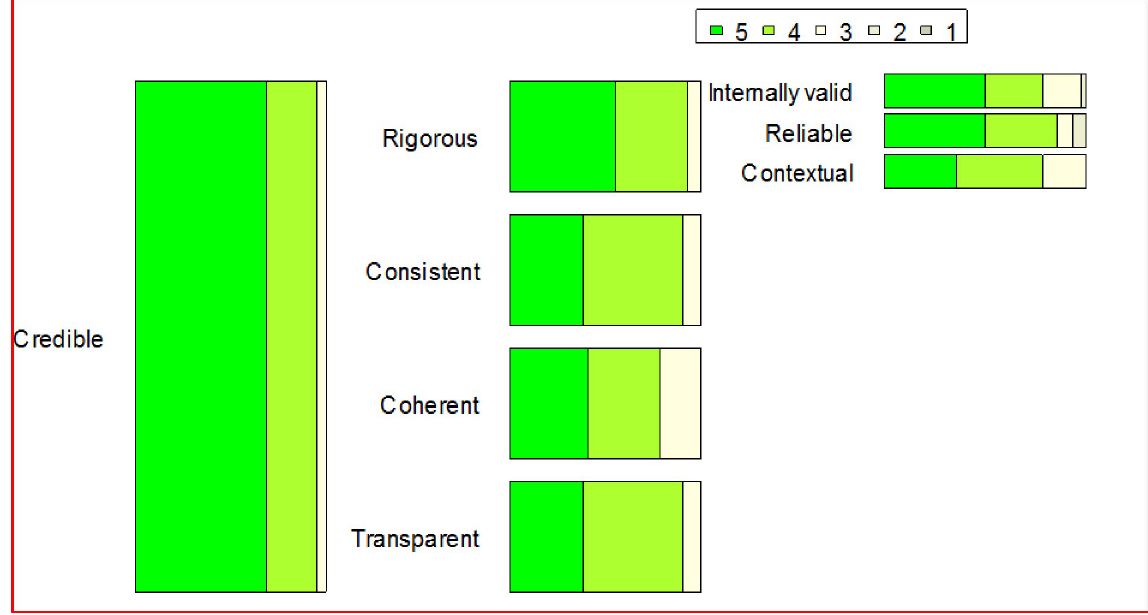
Fig 2. Responses regarding the credible main concept, ranked from 1–5, where 5 is “of crucial